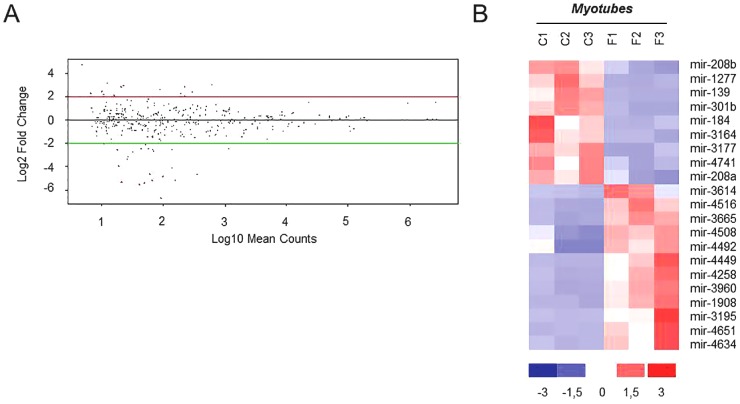
MiRNA dysregulation in FSHD myotubes.A) DEseq analysis of miRNAs differentially expressed in FSHD myotubes vs control myotubes. MiRNAs showing a differential expression of log2FC≥2 and a p-value<0.05 are shown as red dots. B) Hierarchical clustering of the 21 modulated miRNAs (12 up-regulated and 9 down-regulated) in regard to the analyzed samples. C1:MX01010MBS; C2: MX03609MBS; C3: MX01110MBS, Control cell lines; F1:MX00409MBS; F2: MX03010MBS; F3:MX04309MBS, FSHD cell lines (see Table S1).